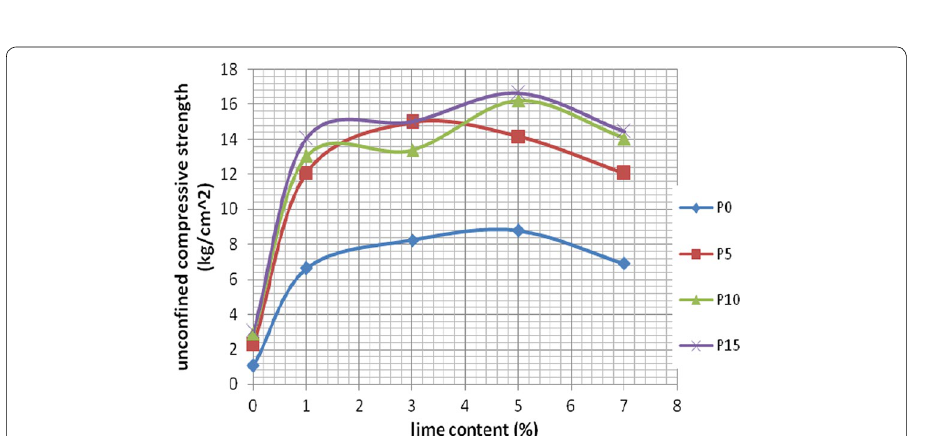
Fig. 5 Effects of lime content on compressive strength of samples having different pozzolan